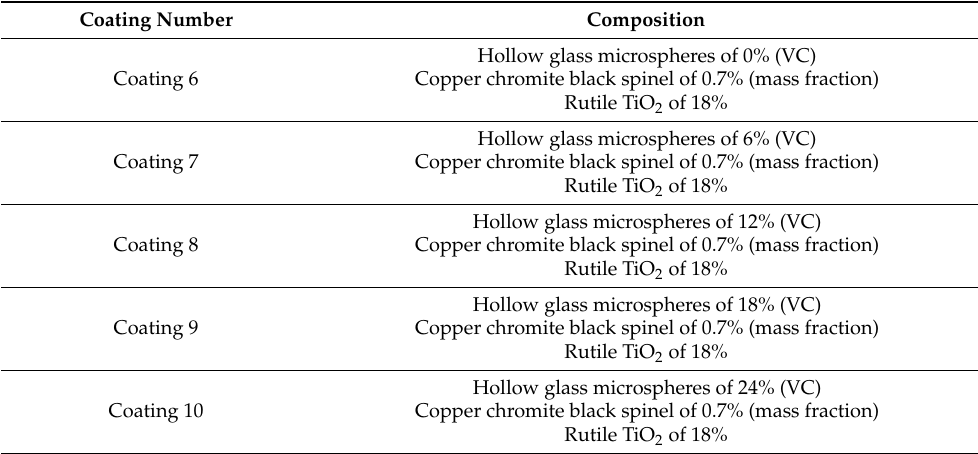
Table 6. CCCLs containing different contents of hollow glass